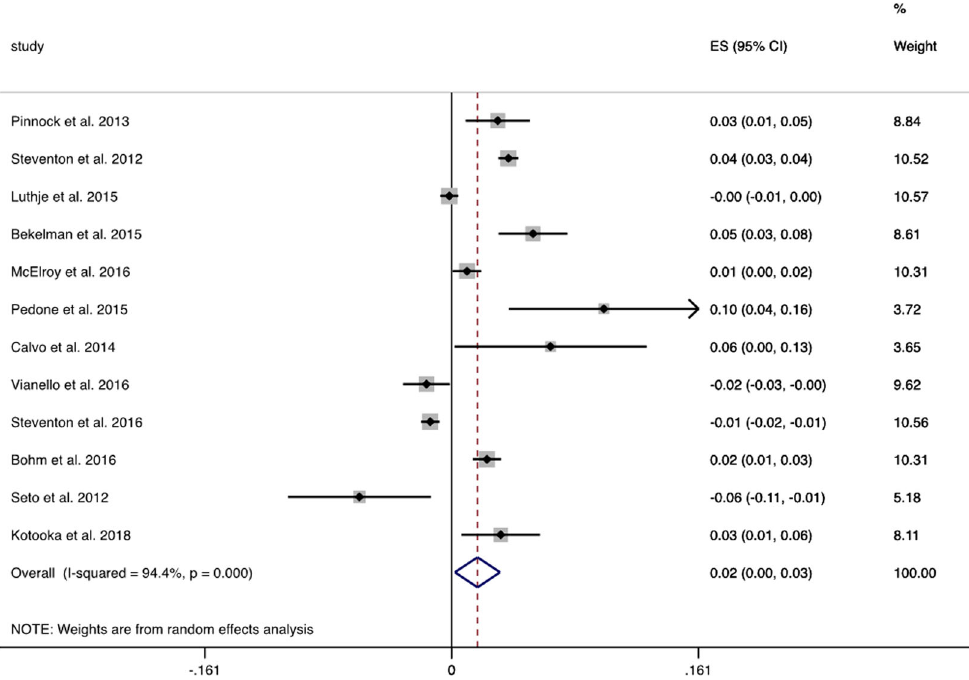
Fig. 3 Forest plot mortality. Forest plot of studies reporting all-cause